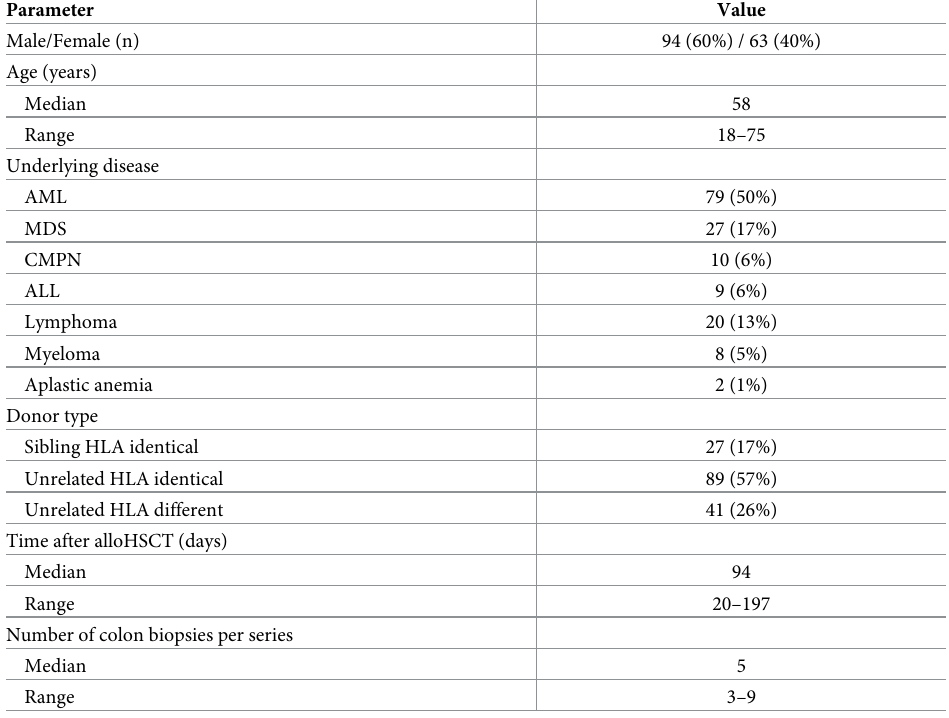
Table 1. The patient’s characteristics.